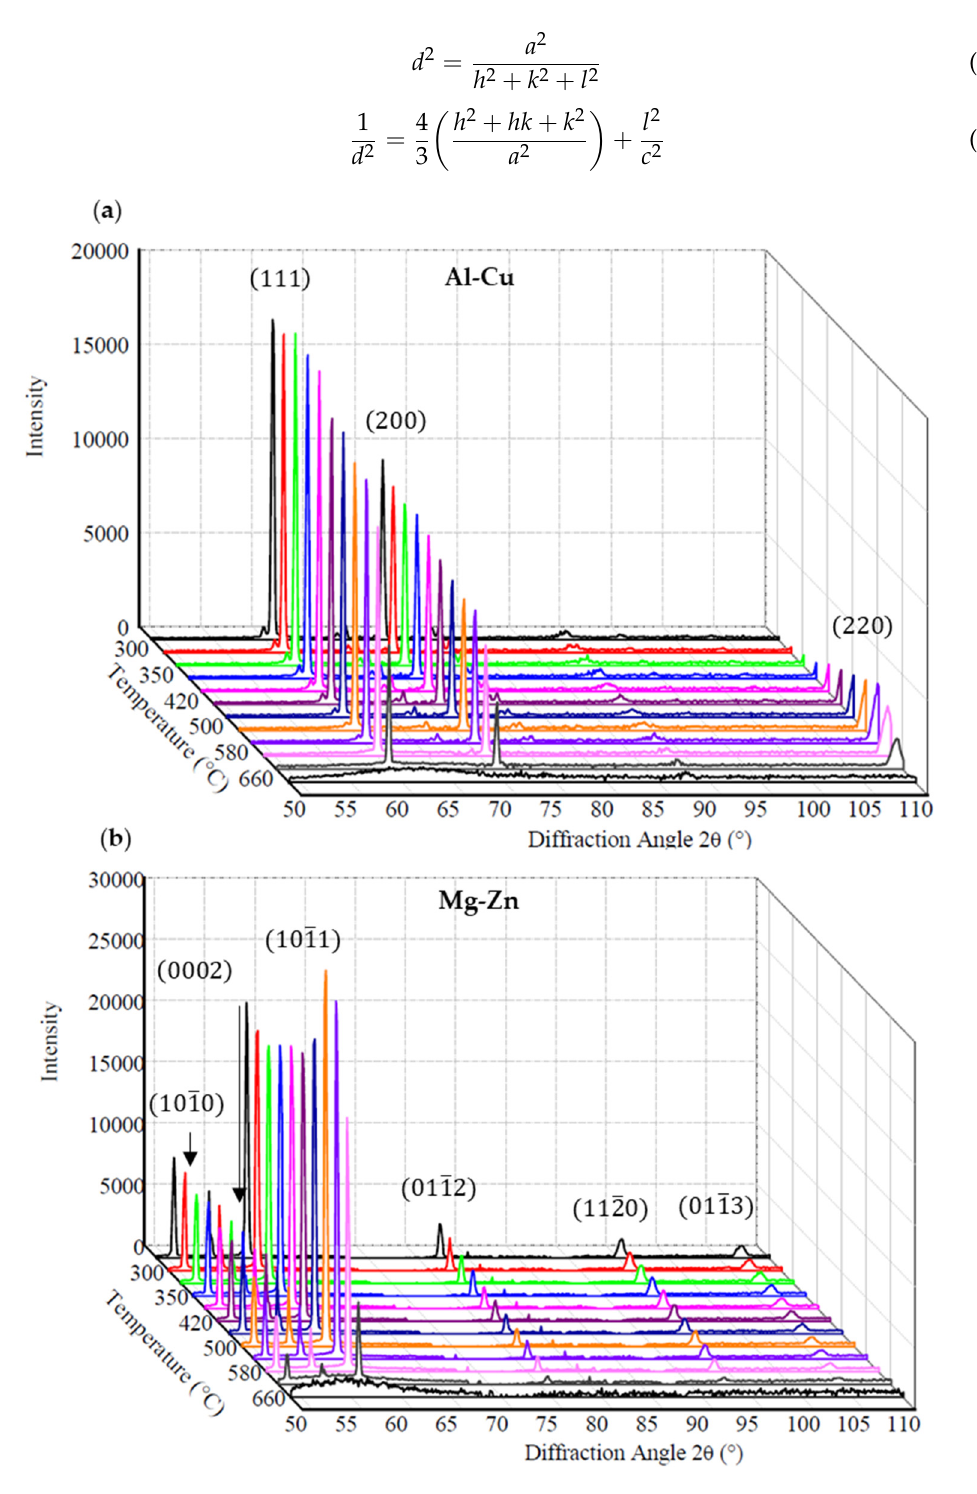
Figure 4. In-situ neutron diffraction plots of ( a ) Al-Cu and ( b ) Mg-Zn at different temperatures (°C, select isotherms omitted for clarity).